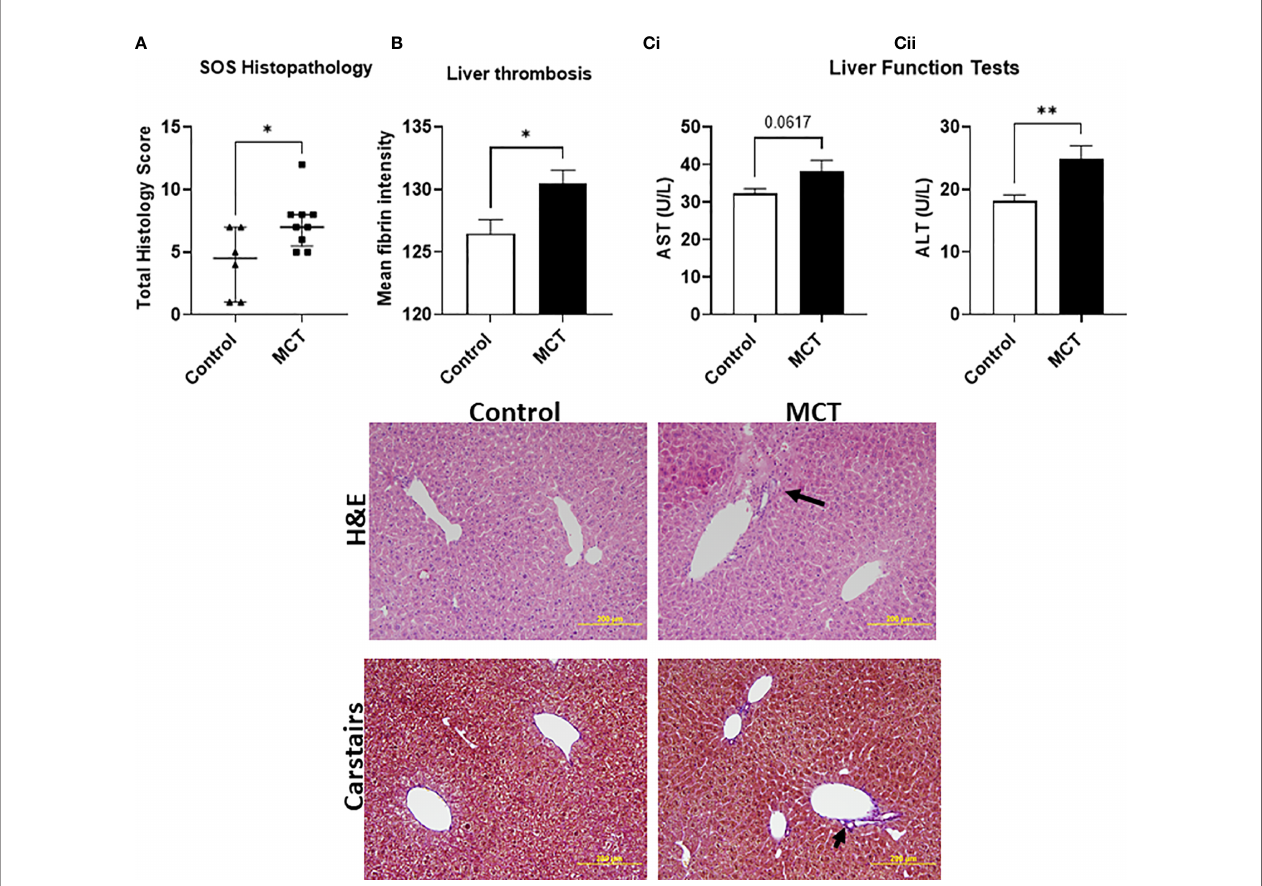
FIGURE 7 | SOS can be directly induced with monocrotaline-mediated endothelial toxicity: (A) Increased hepatic damage reported via histological analysis (Data is median and interquartile range, *=p < 0.05 Mann-Whitney U-test) and (B) increased thrombosis in the liver as well as (C) (i) a trend towards increased aspartate aminotransferase (AST) and (ii) signi fi cantly increased alanine aminotransferase (ALT) levels con fi rming pronounced hepatic damage.). *p < 0.05, **p < 0.005, unpaired Student ’ s t-test; n=7 BM and BM+T cells. Data is Mean ±